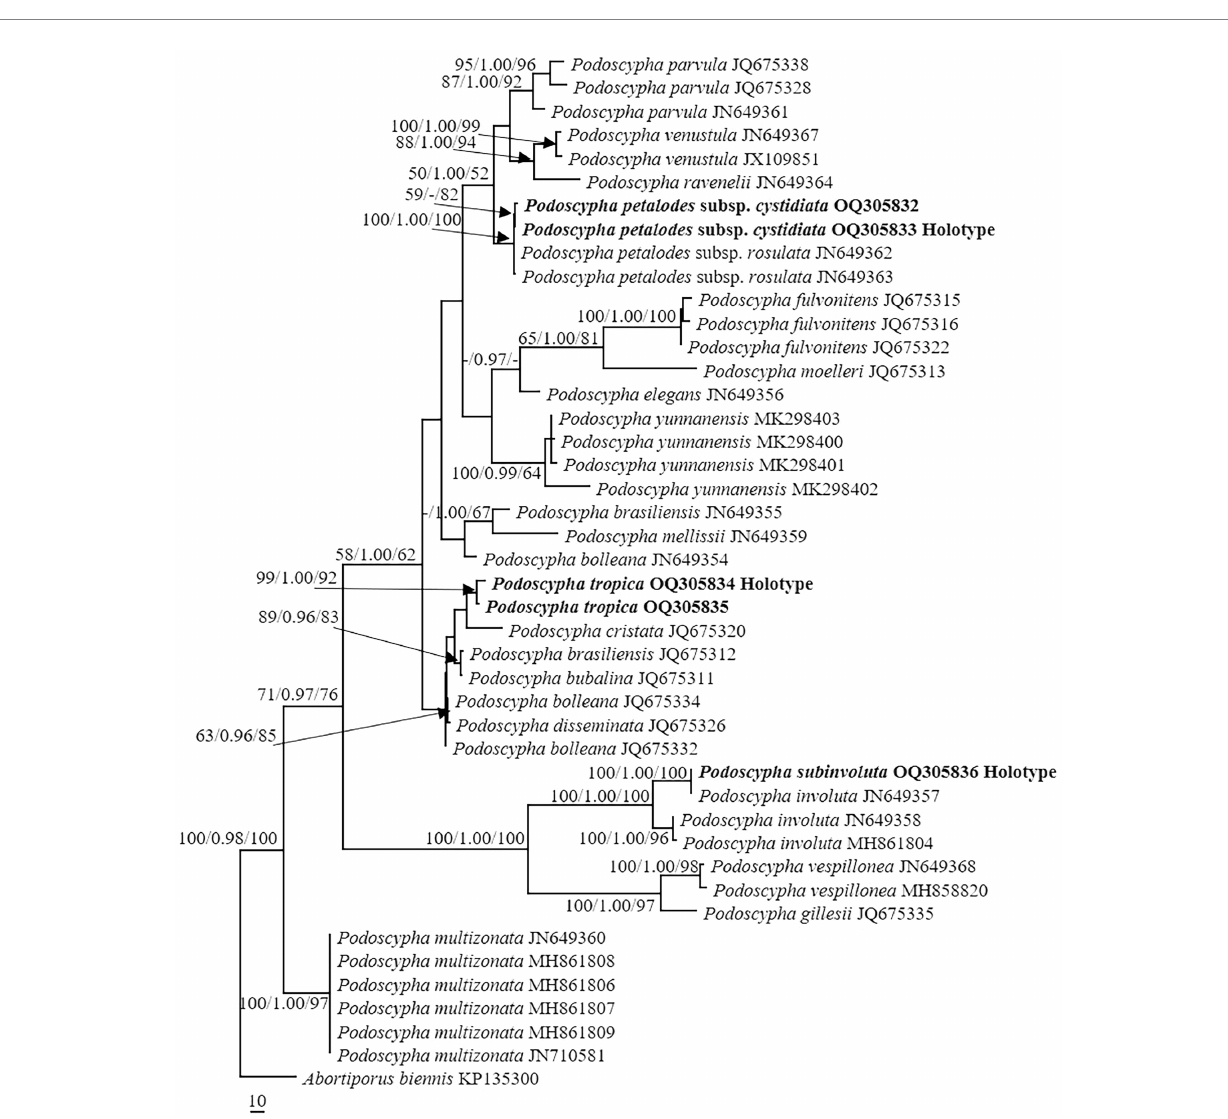
FIGURE 1 Phylogeny of Podoscypha by maximum parsimony (MP) analyses based on internal transcribed spacer (ITS) sequences. Branches are labeled with MP bootstrap >50%, Bayesian posterior probabilities >0.95, and maximum likelihood bootstrap >50%. New species and subspecies are indicated in